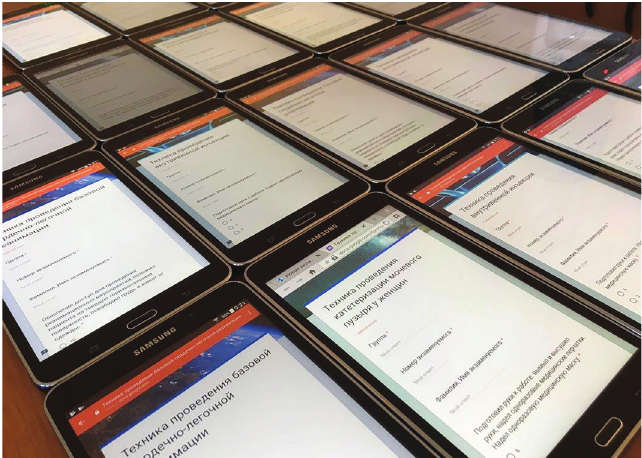
Objective Structured Clinical Examination